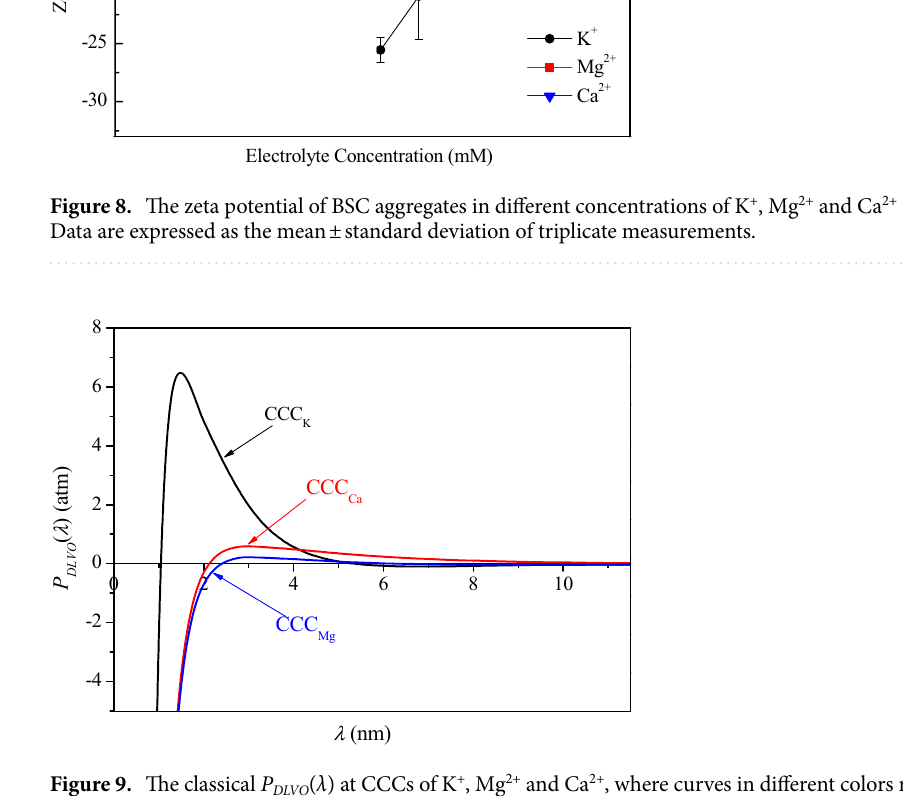
Figure 9. The classical P DLVO ( λ ) at CCCs of K + , Mg 2+ and Ca 2+ , where curves in different colors represent the different cation systems; the areas of closed curves P DLVO ( λ ) versus λ were utilized to estimate the energy barrier, Δ W with a unit of